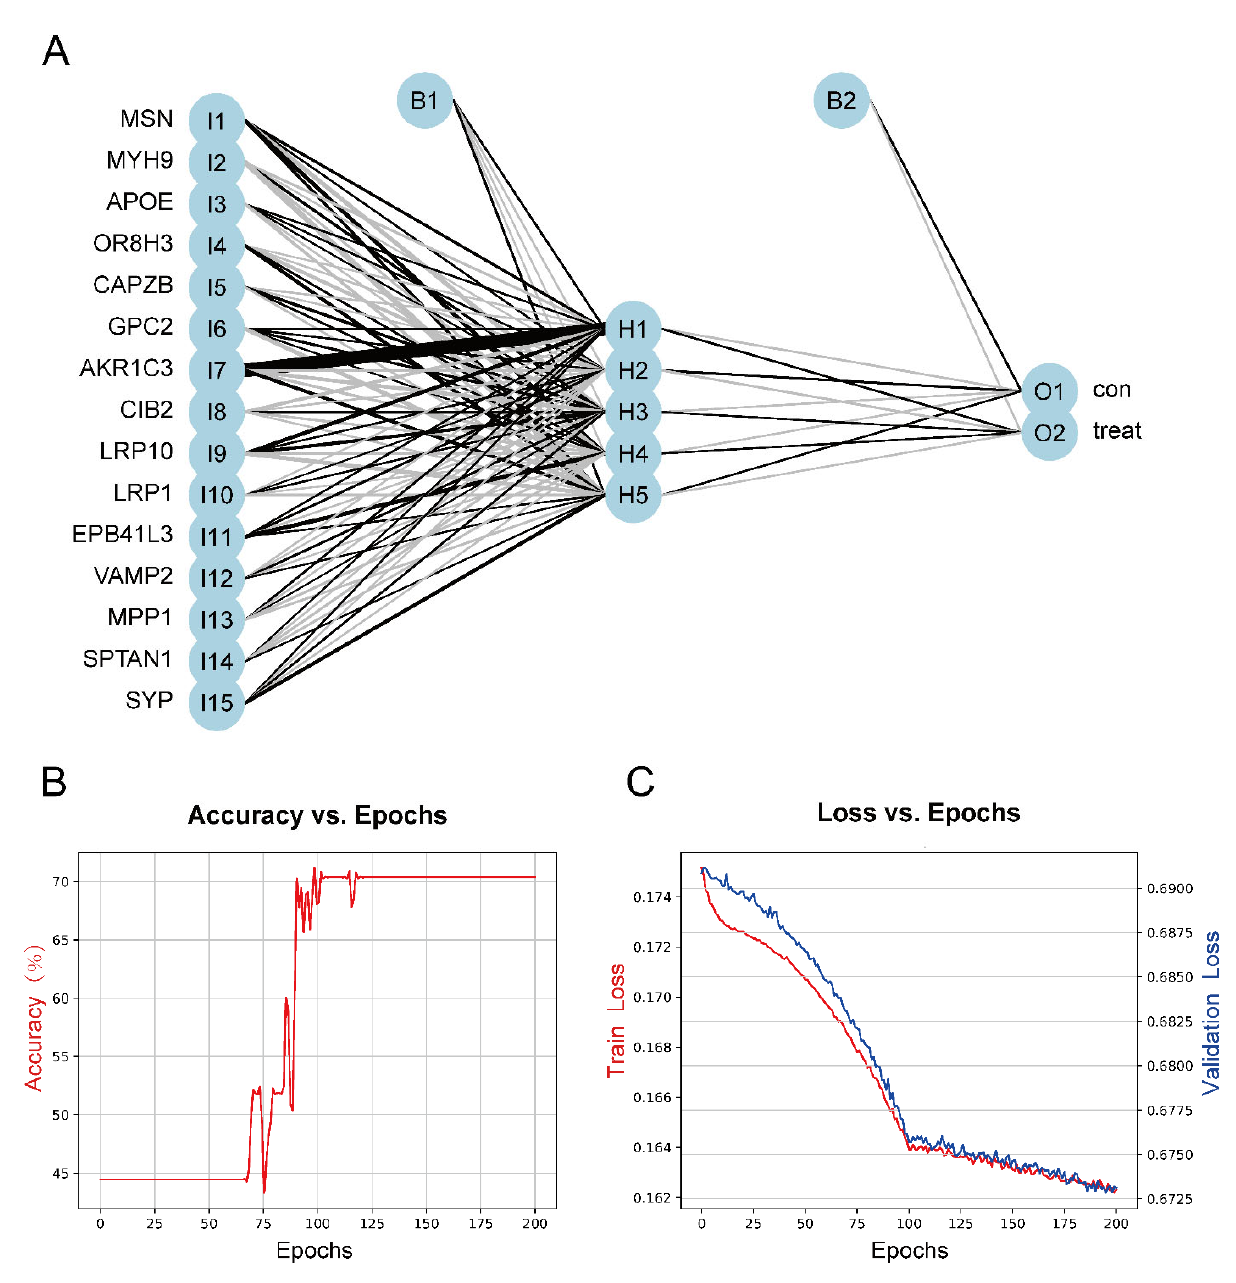
Figure 7. ( A ) The visualization of the neural network results. ( B ) Figure of accuracy vs. epochs. ( C ) Figure of loss vs. epochs.